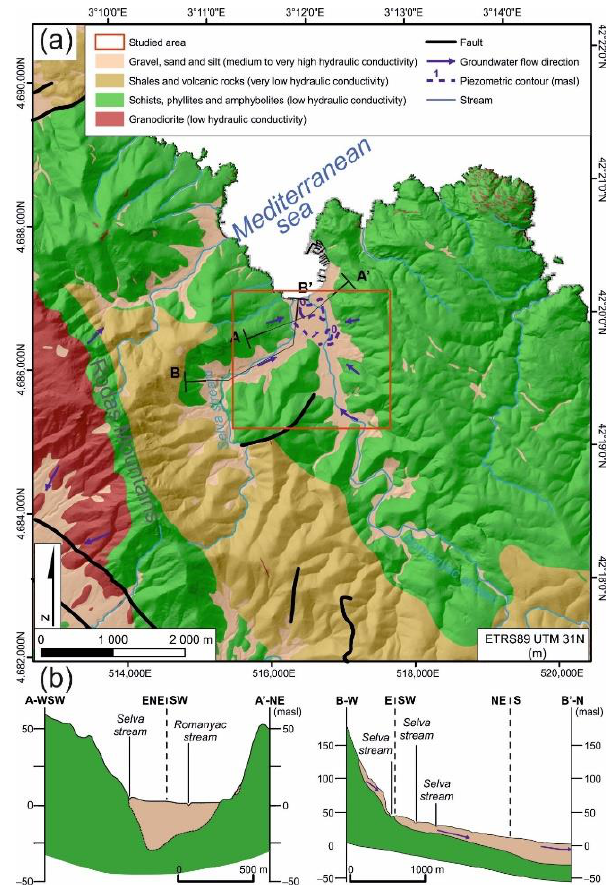
Figure 3. ( a ) Hydrogeological setting of Port de la Selva; ( b ) simplified geological cross-sections of Port de la Selva coastal area. Modified from References [42,43].